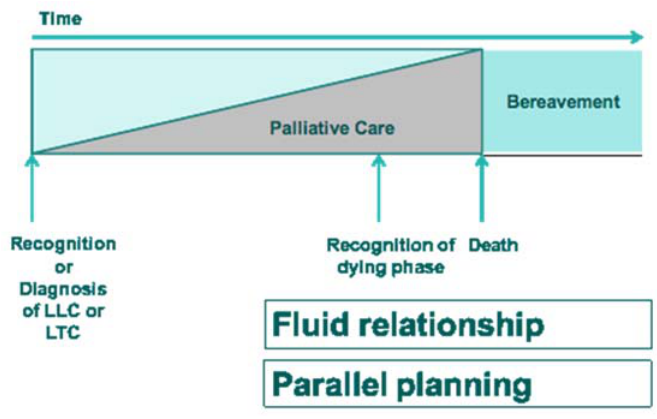
Figure 2. Model of Paediatric Palliative Care.